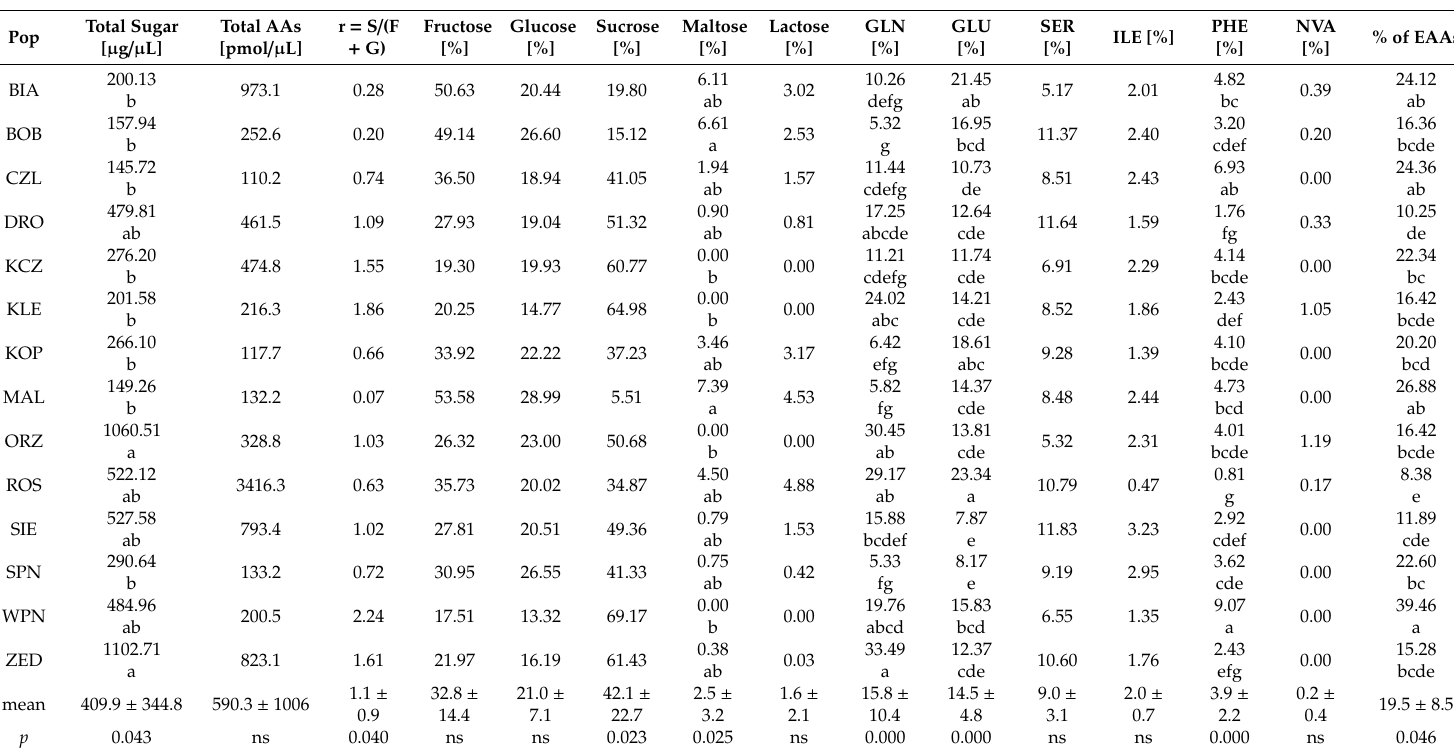
Table 1. Means of the total sugar and amino acid (AA) concentration, sucrose / hexose ratio (r), sugars, and AAs selected for the model, and essential AAs (EAAs) of Polemonium caeruleum nectar for 14 studied populations. Pop (population); GLN (glutamine), GLU (glutamic acid), SER (serine), ILE (isoleucine), PHE (phenylalanine), NVA (norvaline). Within a column, two values with a di ff erent letter are significantly di ff erent at p < 0.05; n = 2 for each population (except BOB, where n =